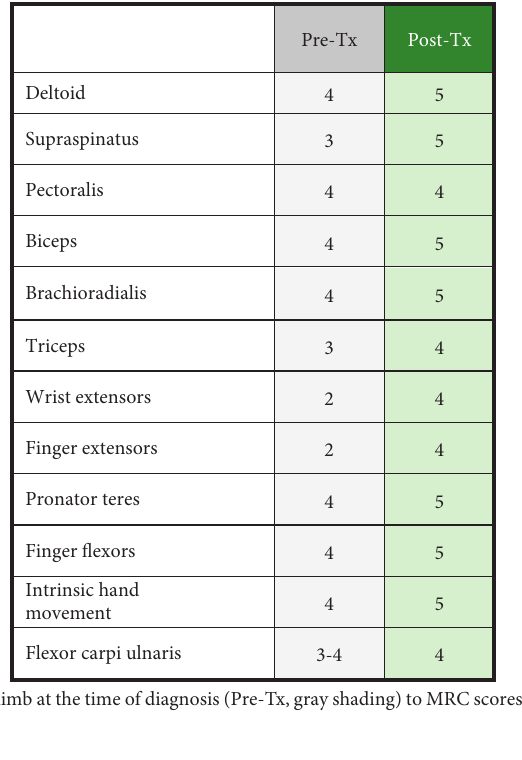
Table 1: Summary of Medical Research Council (MRC) scores of right limb before and after IVIG treatment.